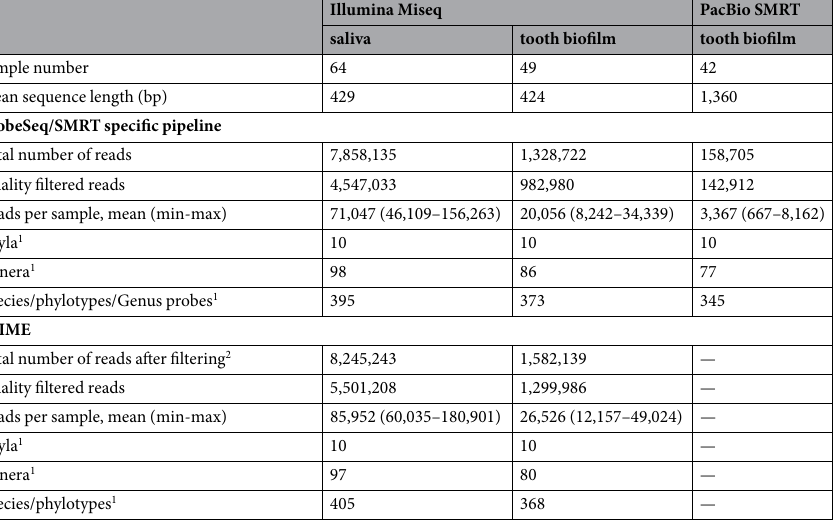
Table 1. Overview of Illumina MiSeq sequencing by bioinformatic processing and PacBio SMRT sequencing. 1 For ProbeSeq and QIIME, OTUs with < 10 sequences per OUT were excluded and for PacBio SMRT those with < 2 sequences per OUT. 2 After split library using default QIIME